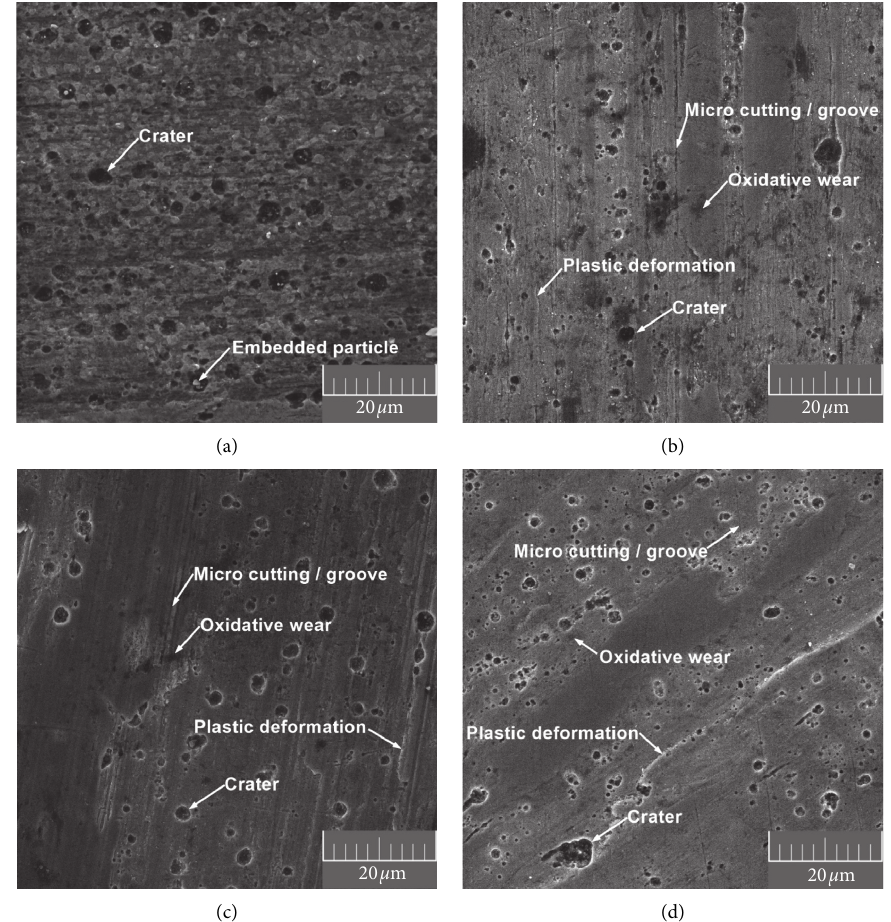
Figure 8: SEM micrographs of worn surfaces of (a) CHTspecimens and CTspecimens treated at (b) − 120 ° C, (c) − 160 ° C, and (d) − 196 °